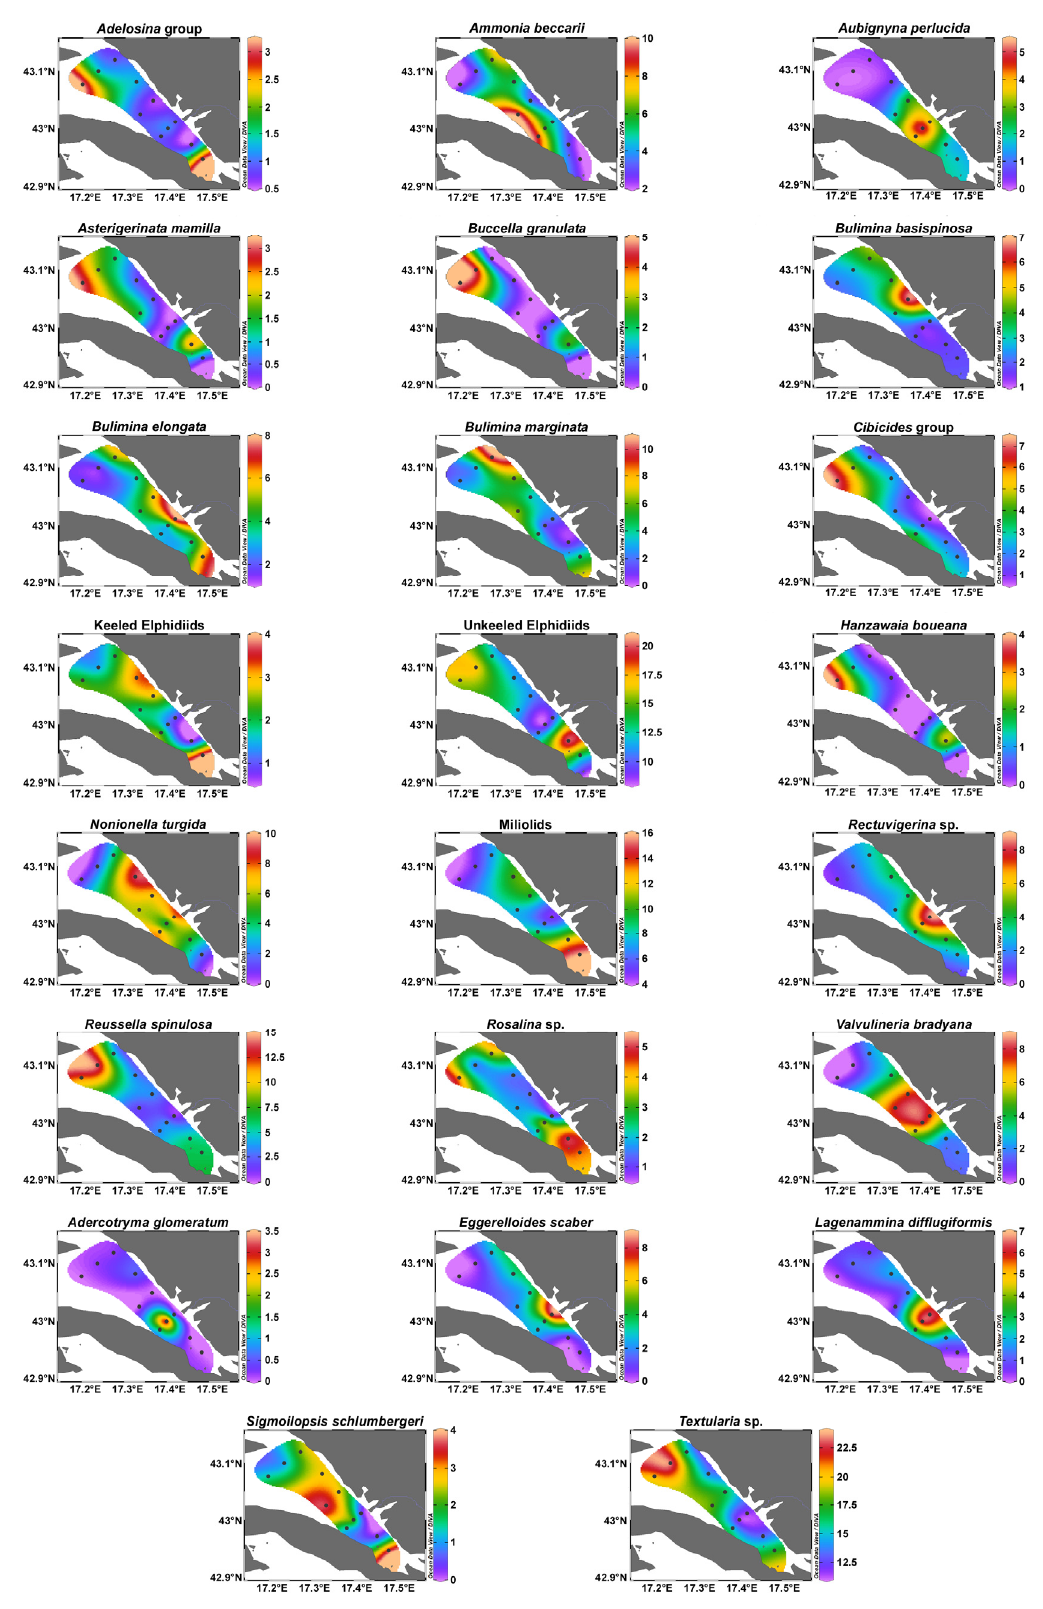
Figure 3. Relative abundance (percentage) and spatial distribution of the most representative species as reported in Table 2. Black dots correspond to study sites; gray and white colors indicate land and sea areas respectively.